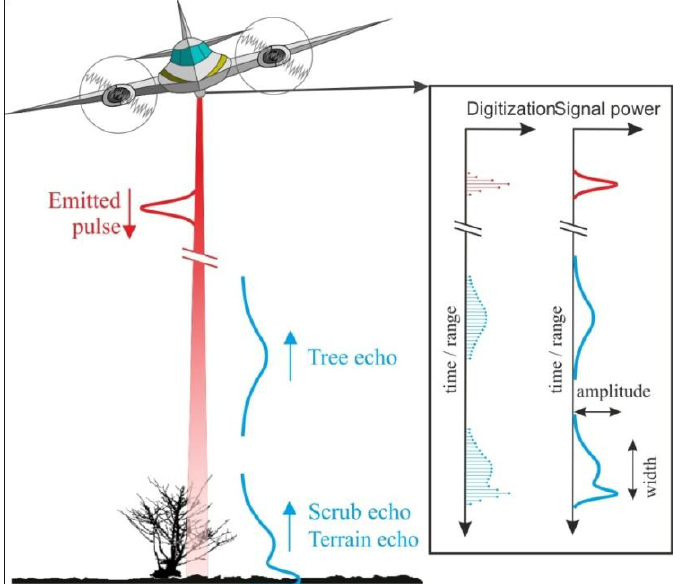
Figure 4. Schematic representation of a FWF-ALS system. A Gaussian decomposition is applied to derive echo widths, which are used for the parameterization of surface roughness. [adapted from